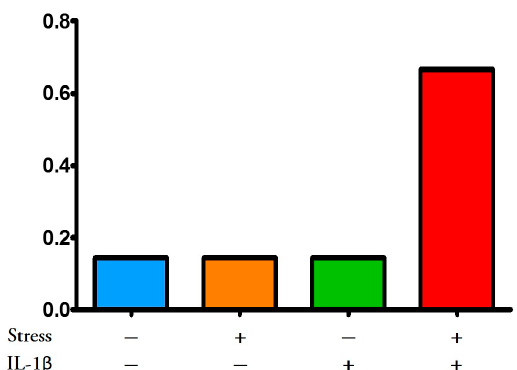
Figure 3. Adverse pregnancy outcomes in rats; frequency distribution. Two-hit hypothesis. Administration of stress (water swimming and restraint from gestational day (GD) 12–18) plus interleukin (IL)-1 β (5 μ g/kg, IP, GD 17-delivery, see Figure 2) to pregnant Long-Evans rats caused more pregnant dams to deliver early (most common outcome), deliver late or have other adverse pregnancy outcomes (dystocia or fetal resorption) than no treatment control, IL-1 β or stress alone. These data support the two-hit allostatic load hypothesis [43].